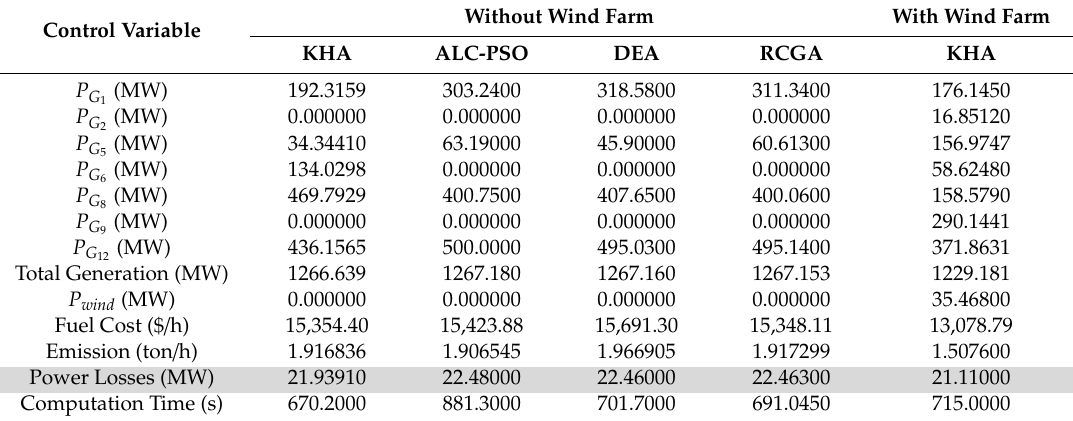
Table 9. Results for minimizing the active power losses across the transmission lines for the Test System 2.